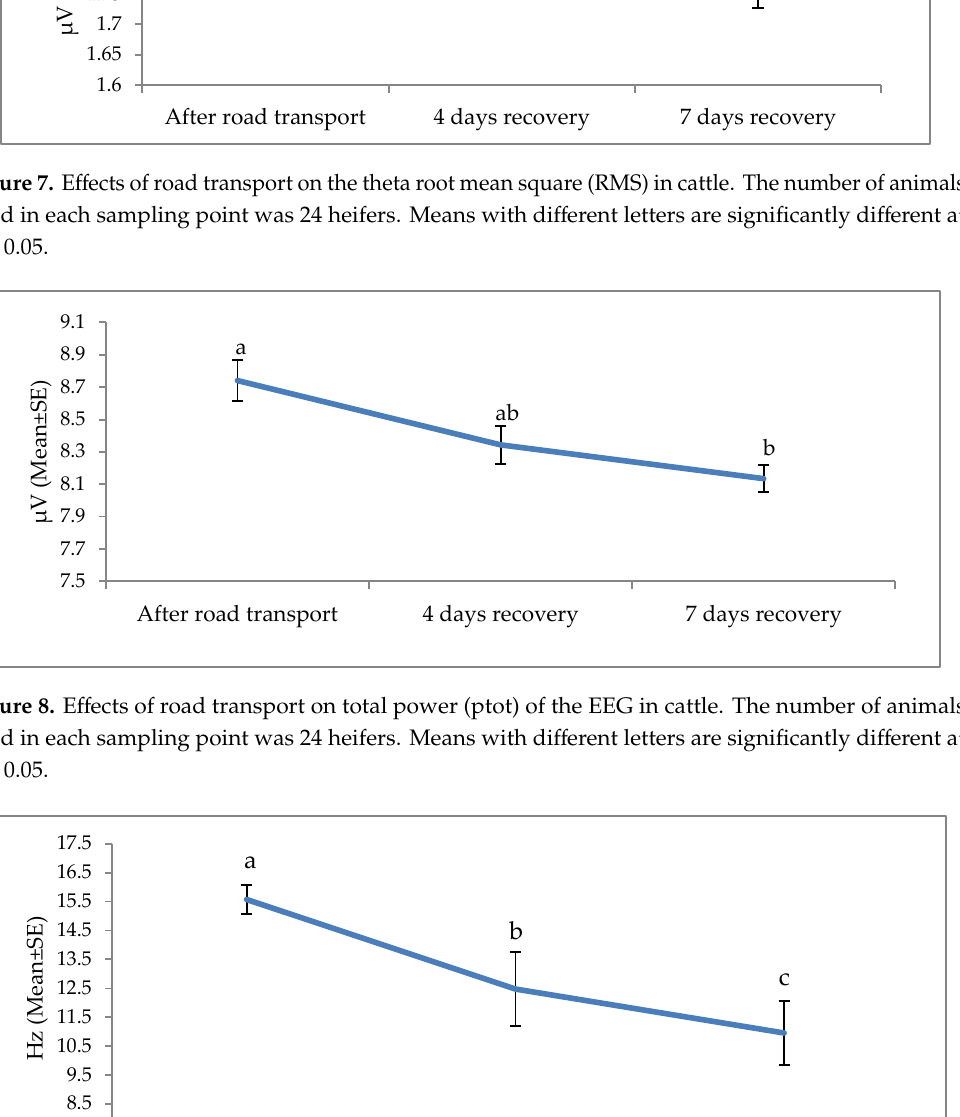
Figure 9. Effects of road transport on the median frequency (MF) of EEG in cattle. The number of animals used in each sampling point was 24 heifers. Means with different letters are significantly different at p < 0.05.